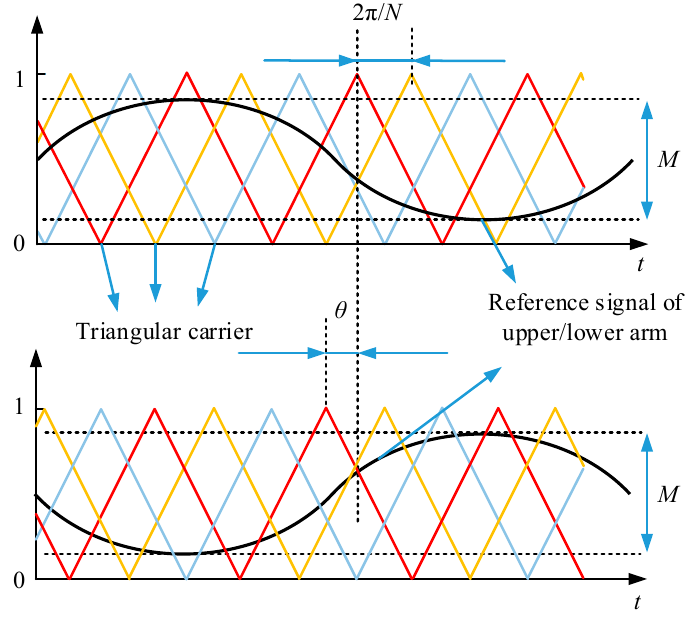
Figure 2. CPS-PWM of MMC.